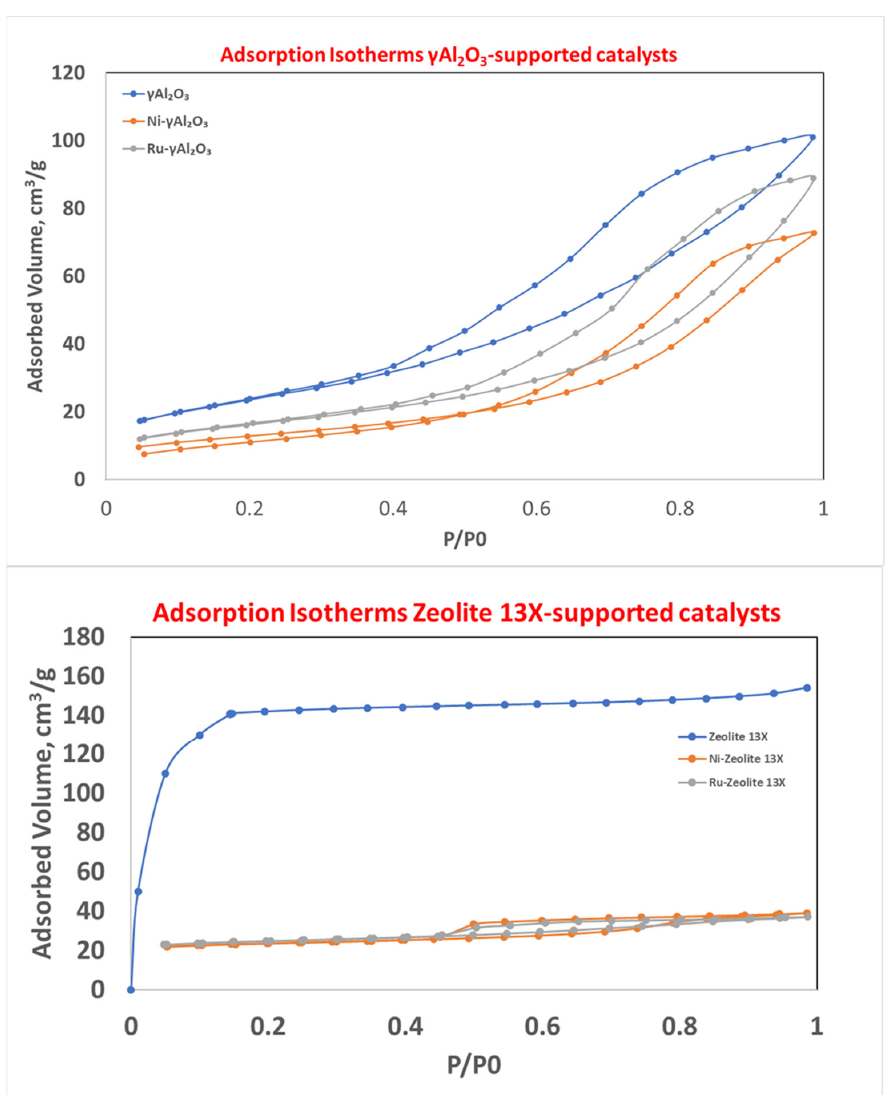
Figure 5. N 2 adsorption–desorption isotherms for γ Al 2 O 3 - (top) and zeolite 13X-supported catalysts (bottom).